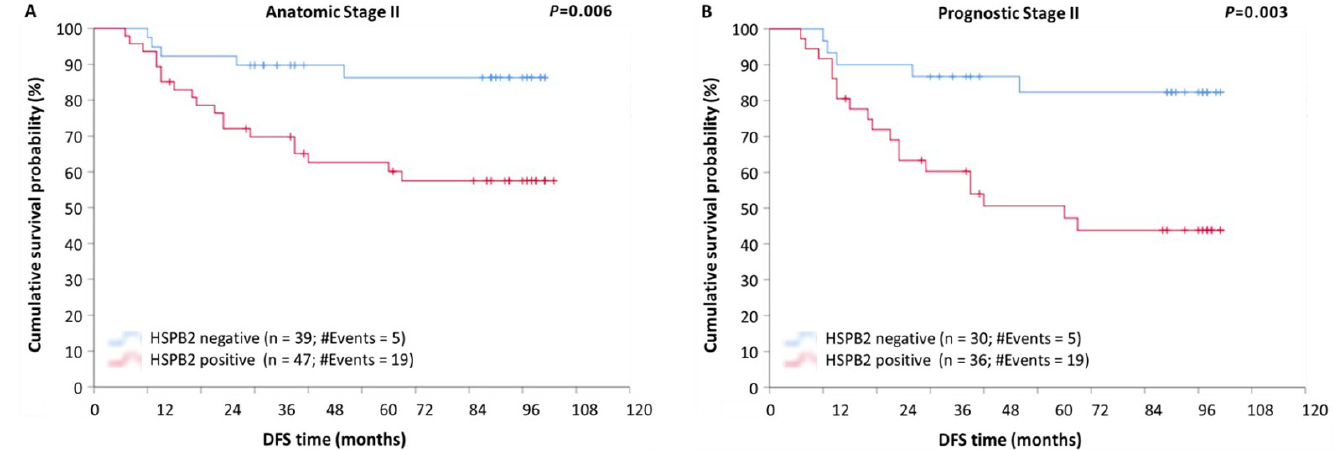
Figure 5. Stratified Kaplan–Meier survival curves for disease-free survival (DFS) of BrCa patients, according to anatomic and prognostic stage. ( A ) Patients with HSPB2 -positive tumors of anatomic stage II had significantly poorer DFS than those with HSPB2 -negative tumors. ( B ) Patients with HSPB2 -positive tumors of prognostic stage II had shorter DFS time intervals than those with HSPB2 - negative tumors. p -value was calculated using the log-rank test.